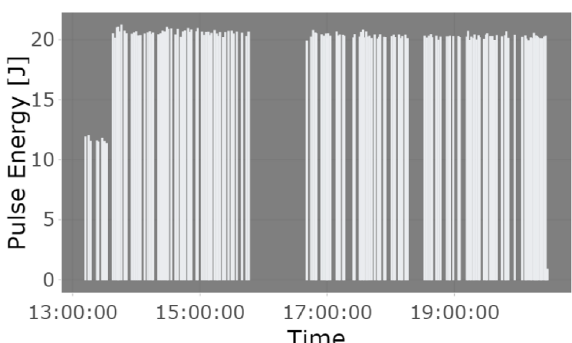
Figure 4. HPLS pulses delivered on a gas target in the 1 PW experimental area (reproduction from